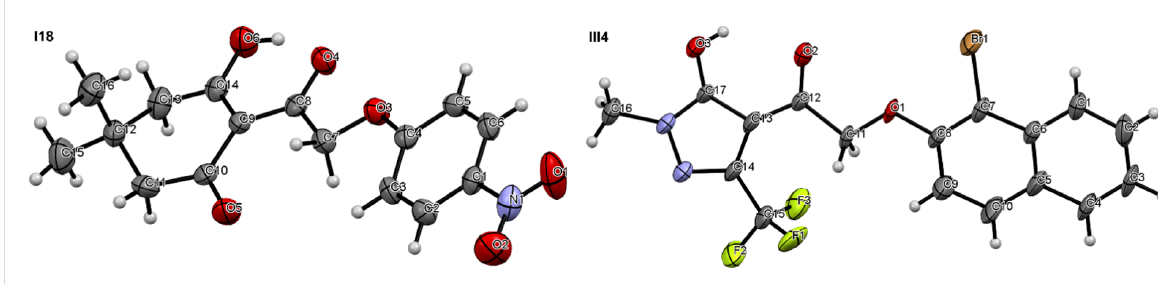
Figure 3: Crystal structures of I18 and III4 .